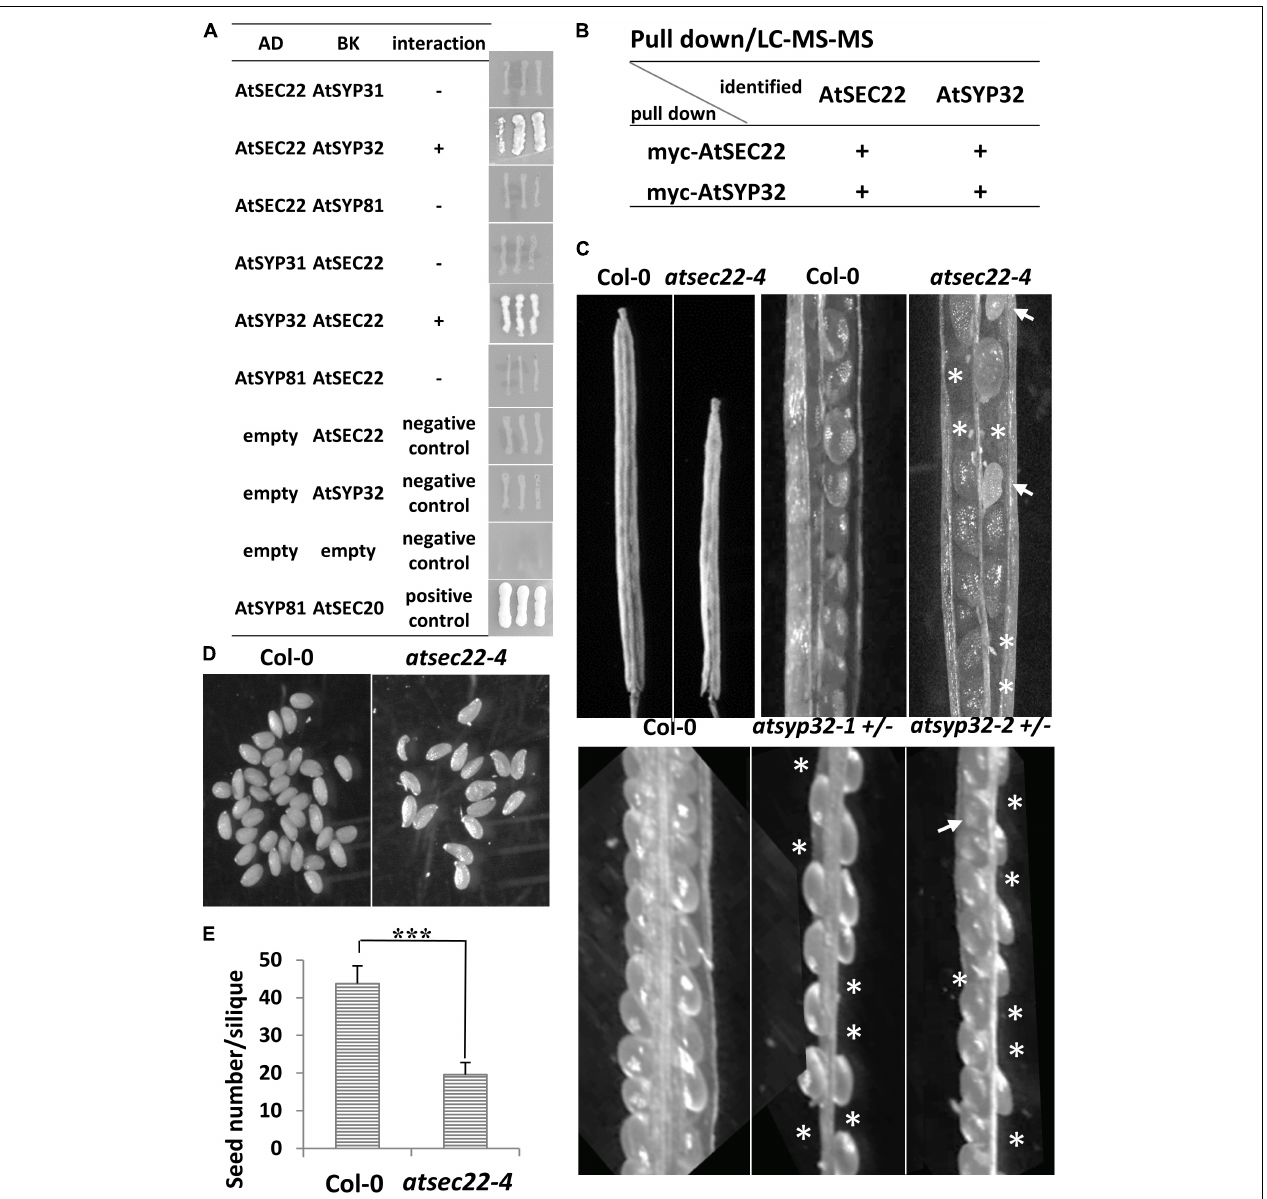
FIGURE 4 | AtSEC22 interacts with Golgi-localized syntaxin AtSYP32. (A) AtSEC22 interacts with AtSYP32 rather than with AtSYP31 and AtSYP81. Plasmid combinations are shown. Yeast strain AH109 was transformed with the paired constructs. Transformants were streaked onto SD/_Leu/_Trp/_His/_Ade medium. +, interaction; –, no interaction; AD, pGADT7; BK, pGBKT7. (B) Pull down assay using myc- AtSEC22 -overexpressing plants followed by shotgun LC-MS/MS analysis. As a results, AtSYP32 was identified. Inverse experiments identified AtSEC22. (C) atsec22-4 , atsyp32-1 ± , and atsyp32-2 ± had smaller siliques and were partially abortive. Asterisks, positions of abortive seeds; arrows, poorly developed seeds. (D) Siliques in atsec22-4 had fewer seeds than those in wild-type. The seeds were from one silique. (E) Statistics of panel (D) . n ≥ 15. *** P < 0.001. Significance was evaluated by Student’s t